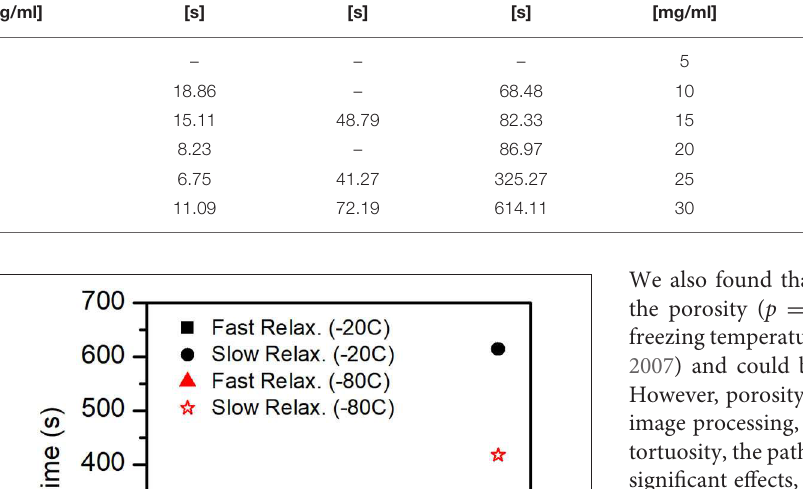
TABLE 6 | Different Relaxation Times for the sponges in different silk concentration and temperatures. Sample conc. ( − 20 ◦ C)